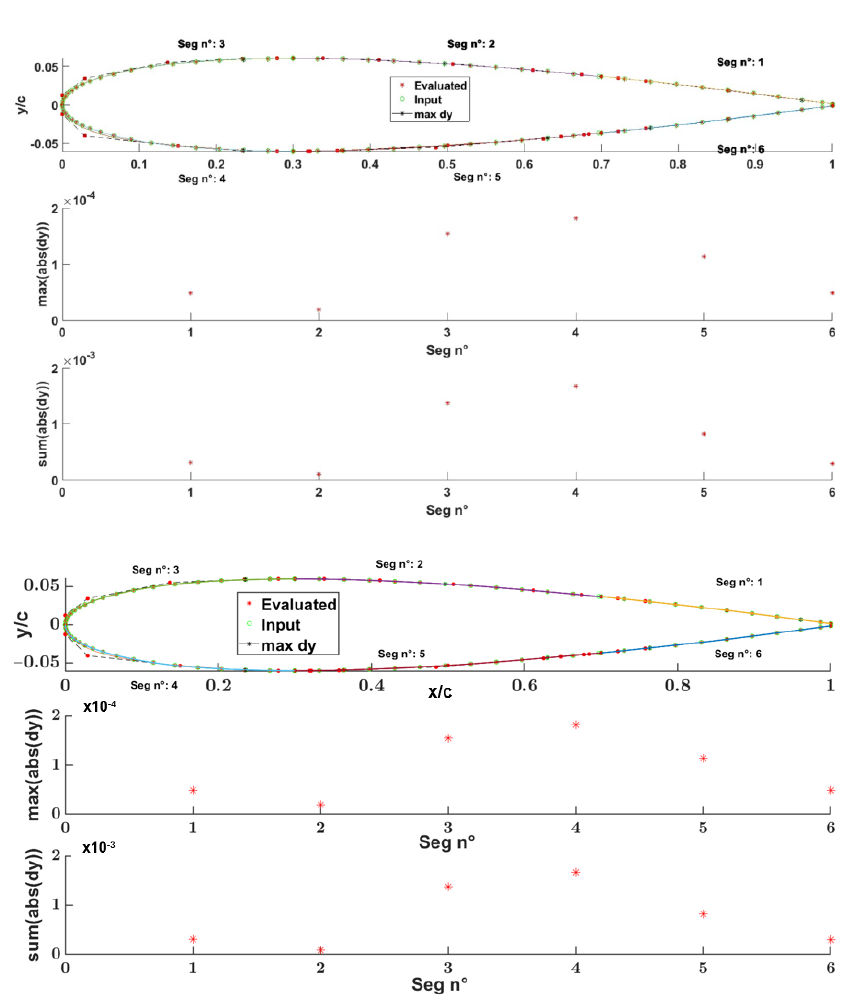
Figure 18. NACA 0012 input and evaluated maximum Euclidean point distance.